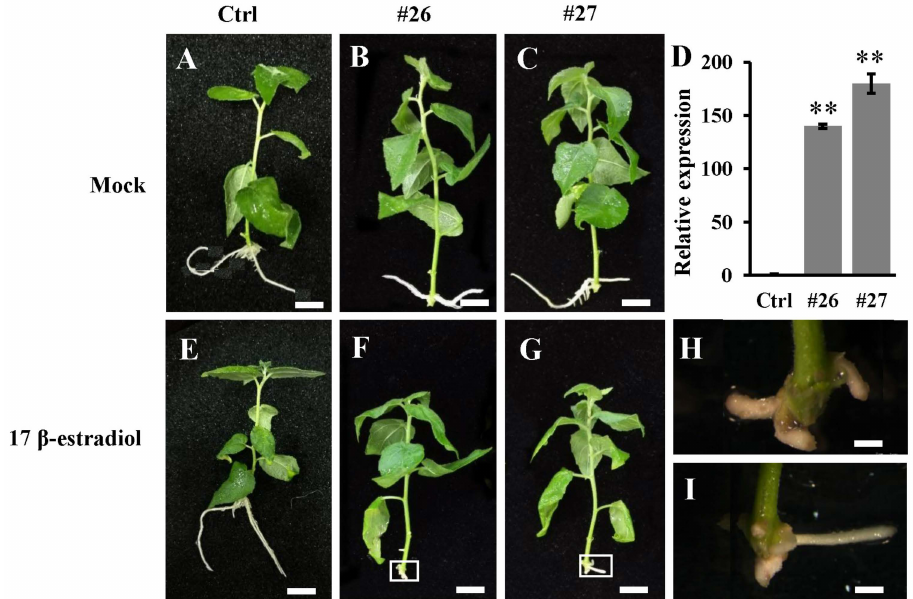
Figure 8. Growth phenotype of Ctrl and p XVE :: PtoWUSa transgenic plants (including two independent transgenic lines #26 and #27) treated with 0 µ M ( A–C ) and 10 µ M ( E – G ) 17 β -estradiol for three weeks. ( D ) Expression levels of PtoWUSa in Ctrl and transgenic plants after treated 10 µ M 17 β -estradiol. ( H , I ) Close-up views of ARs of transgenic line #26 from ( F ) and #27 from ( G ). PtoACTIN was used as reference gene. The expression level in Ctrl was set to 1. ** indicated the di ff erence between Ctrl and each transgenic line at p < 0.01 level. Scale bar: ( A–C , E–G ) = 1 cm; ( H , I ) = 3